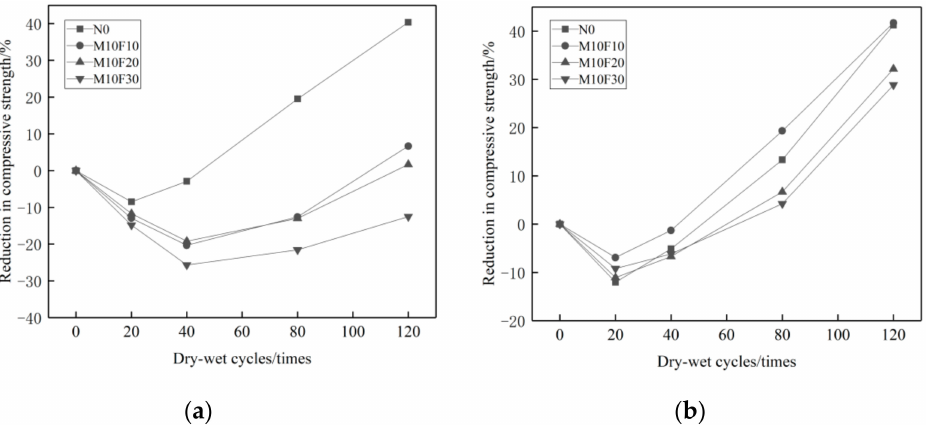
Figure 12. Loss rate of compressive strength of concrete with double admixtures under different erosion conditions. ( a ) 10% Na 2 SO 4 , ( b ) 10% MgSO 4